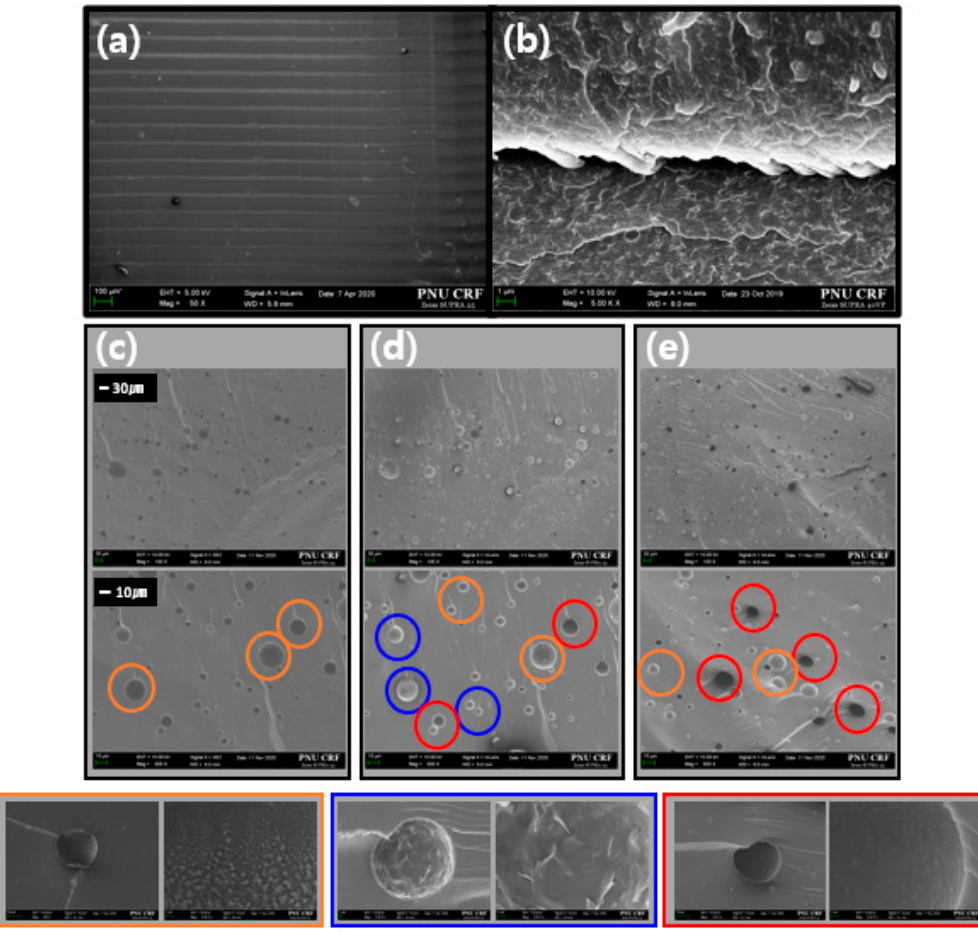
Figure 6. SEM images of the printed 3D structure: ( a , b ) cross-section images; ( c – e ) top view images (Monomer + WPU 5 wt.%, WPU 20 wt.%, WPU 30 wt.%).